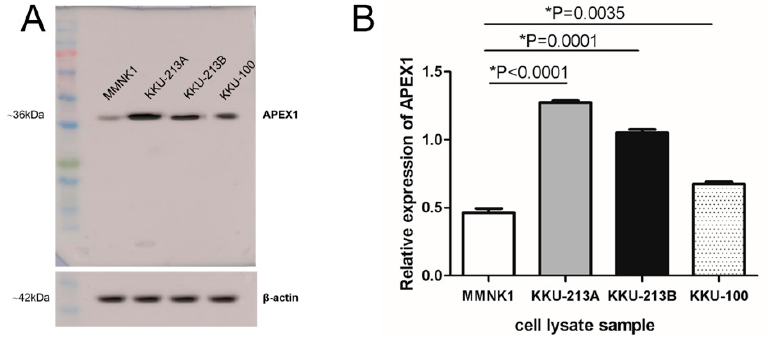
Figure 1. Expression of APEX1 in three CCA cell lines and immortalized cholangiocyte cell line MMNK1. ( A ) Western blot analysis showed a high expression of APEX1 in KKU-213A and KKU-213B. β -actin was used as a control for protein loading. ( B ) APEX1 protein expression was determined using quantitative image analysis. Relative expression of APEX1 was the intensity ratio of APEX1 and β -actin.